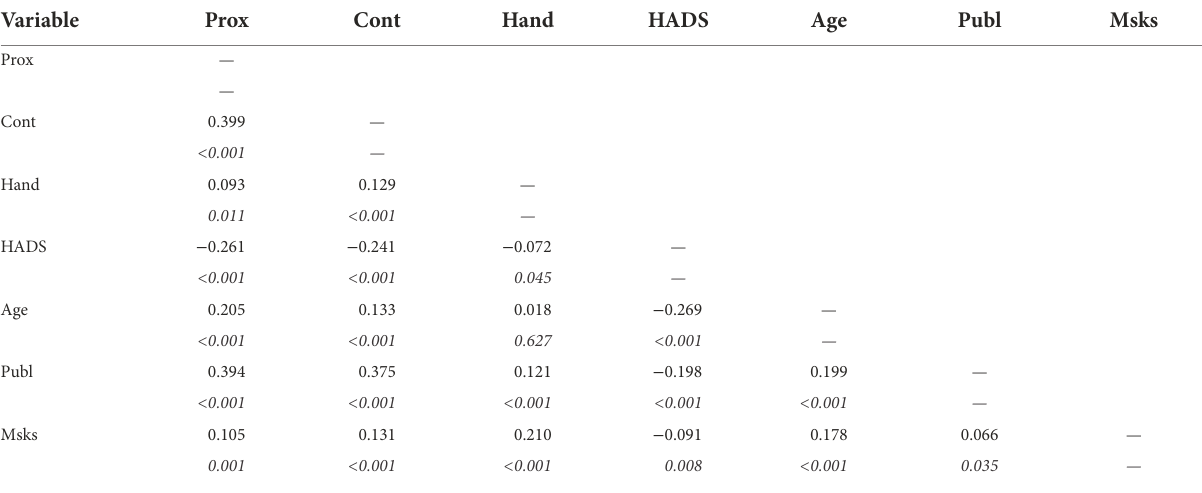
TABLE 2 Intercorrelations (with probabilities in italics) of mitigation behaviors, psychological distress (HADS), and age.